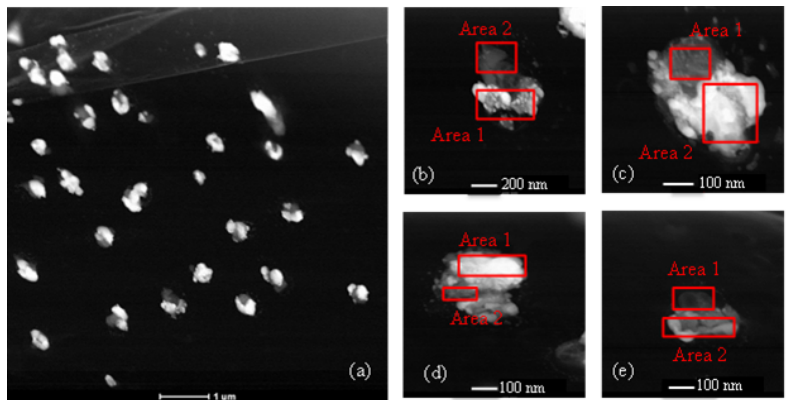
Figure A2. High-angle annular dark field (HAADF) scanning transmission electron microscopy (STEM) of AgI particles formed by pre- cipitation. Panel (a) shows an overview and panels (b–e) individual particles for which EDX (energy-dispersive X-ray) spectroscopy has been performed. Panel (b) : in area 1 silver and iodine were detected with small amounts of oxygen and potassium; in area 2 potassium and chloride were detected. Panel (c) : in area 1 silver and iodine was detected; for area 2 the EDX spectrum showed a large peak for potassium and small peaks for chlorine and oxygen. Panel (d) : area 1 contained mainly silver and iodine, area 2 silver and iodine and possibly small amounts of potassium. Panel (e) : the EDX spectrum of area 1 showed a small peak for potassium and small amounts of silver and iodine, area 2 silver and